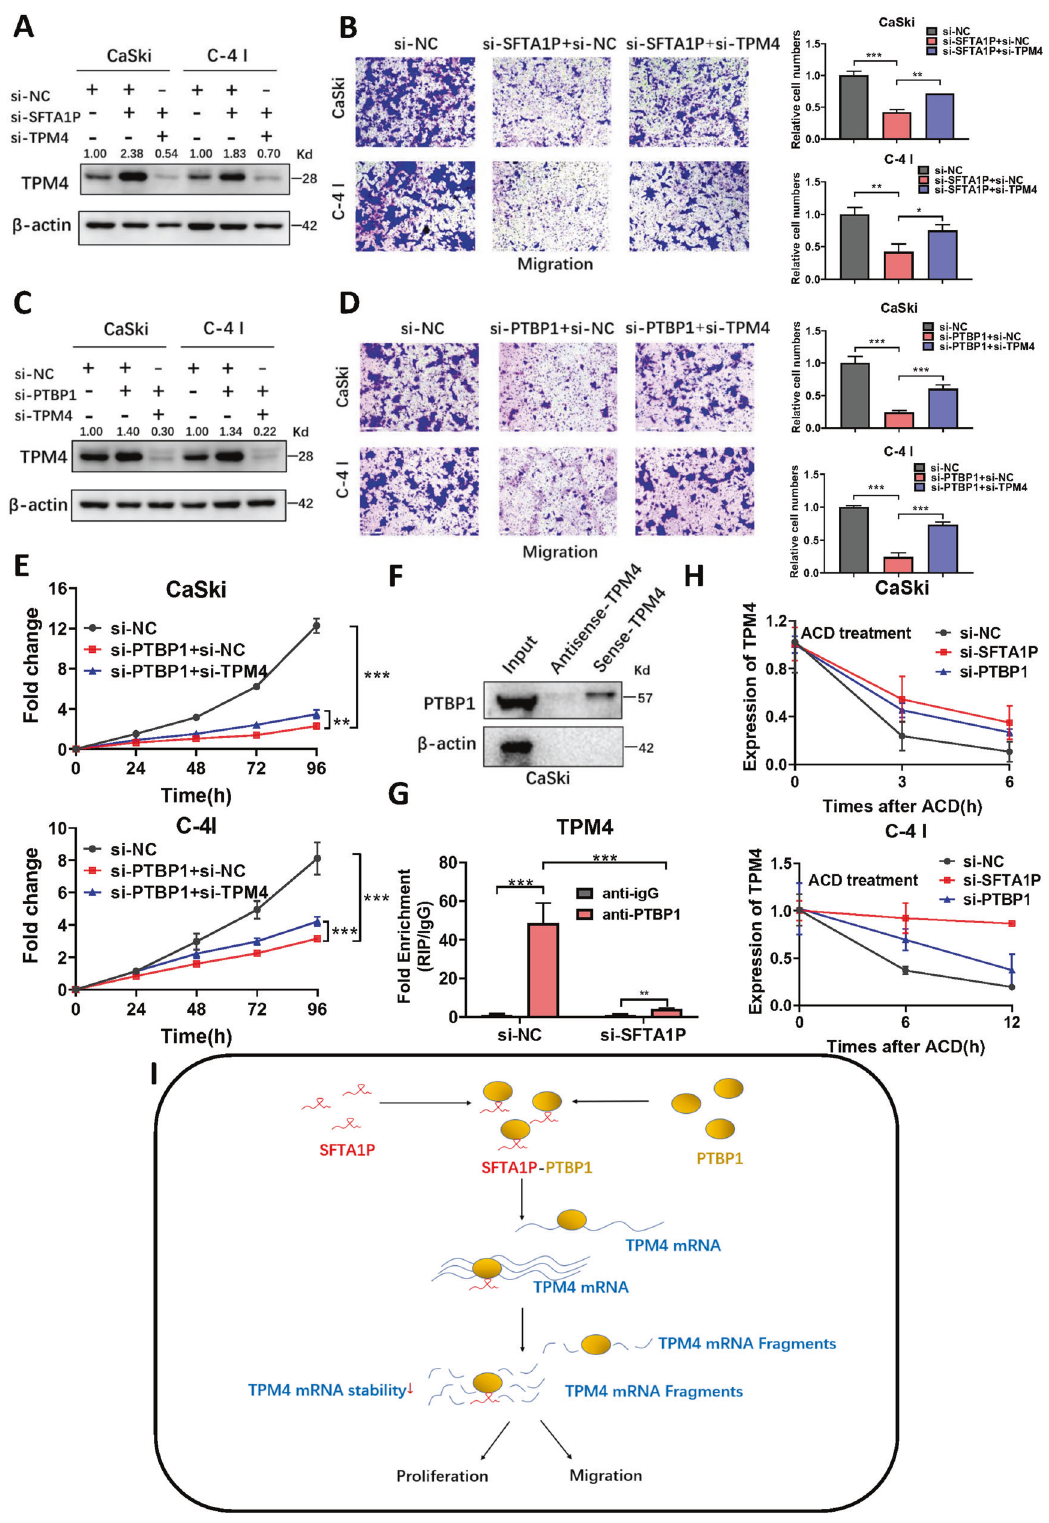
results of SFTA1P knockdown (Supplementary Fig. S3A). between si-PTBP1 and control groups (Supplementary Fig.